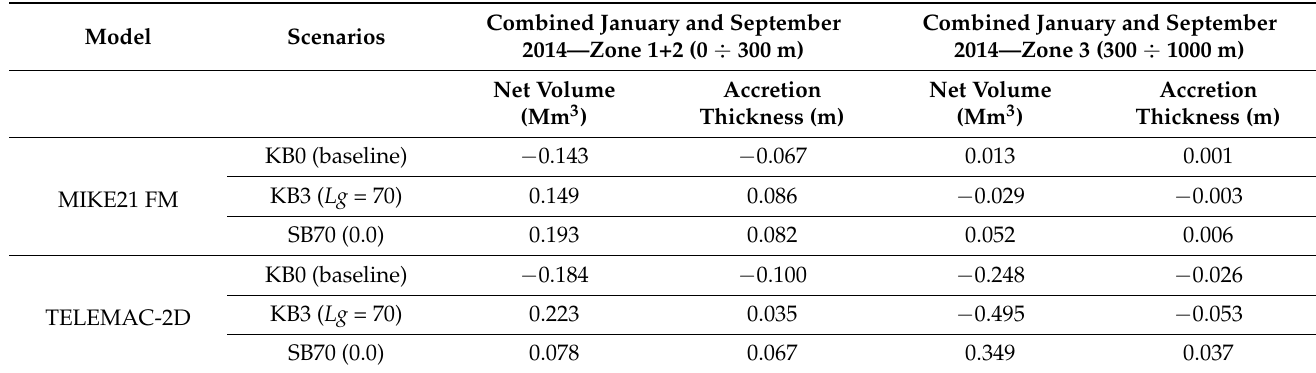
Table 8. Comparison of morphological impacts of breakwaters simulated by MIKE21 FM and